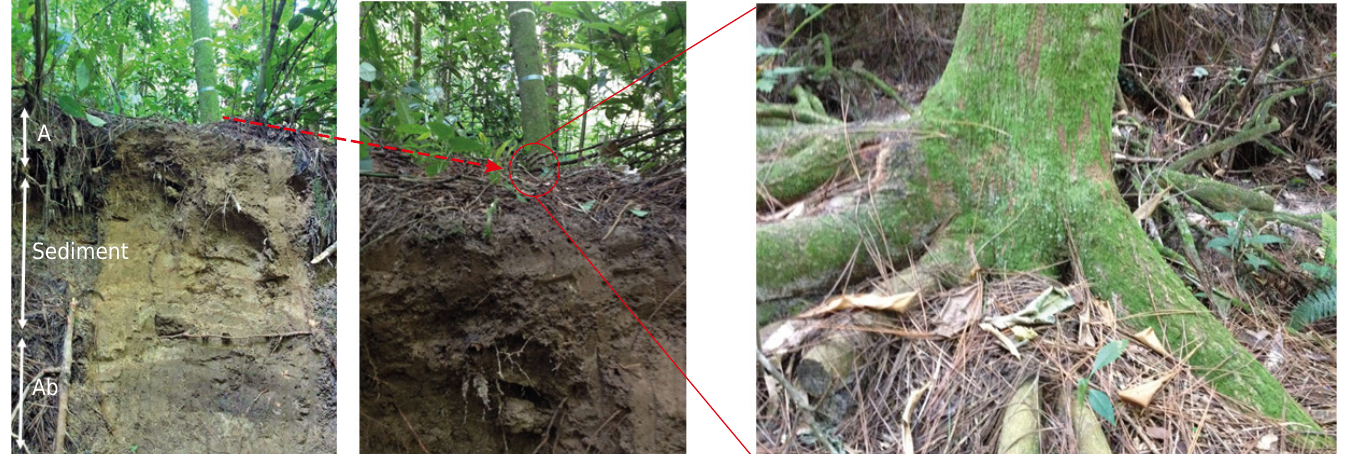
Figure 3. Root collar of the trees that grow in the study area not covered nor exposed by erosion